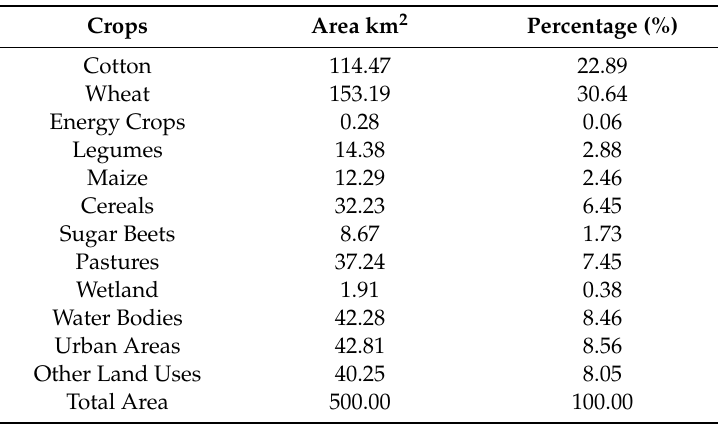
Figure 2. Land Uses and Crop Classification in 2001. Table 1. Land Uses and Crop Classification percentage area.